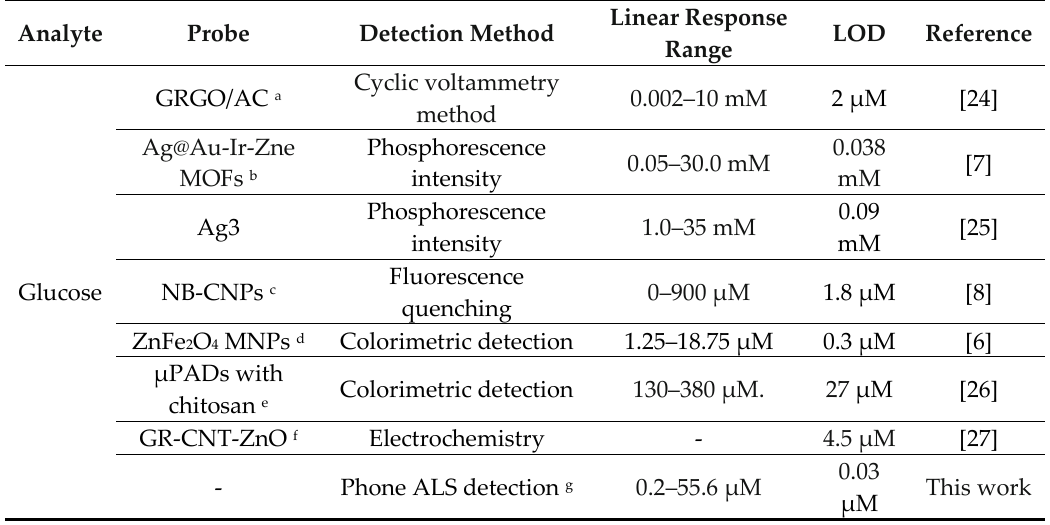
Table 1. Comparison of the analytical methods for glucose